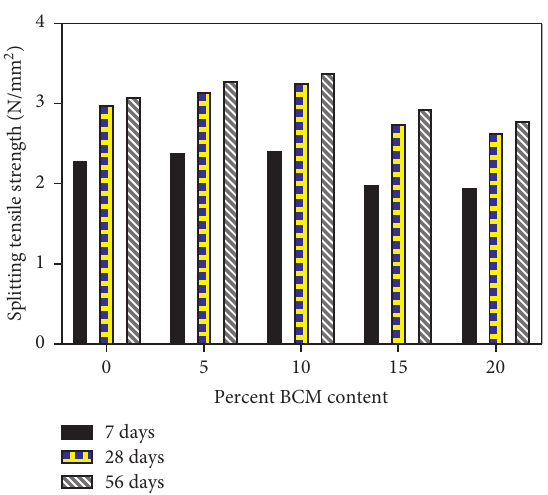
Figure 4: Splitting tensile